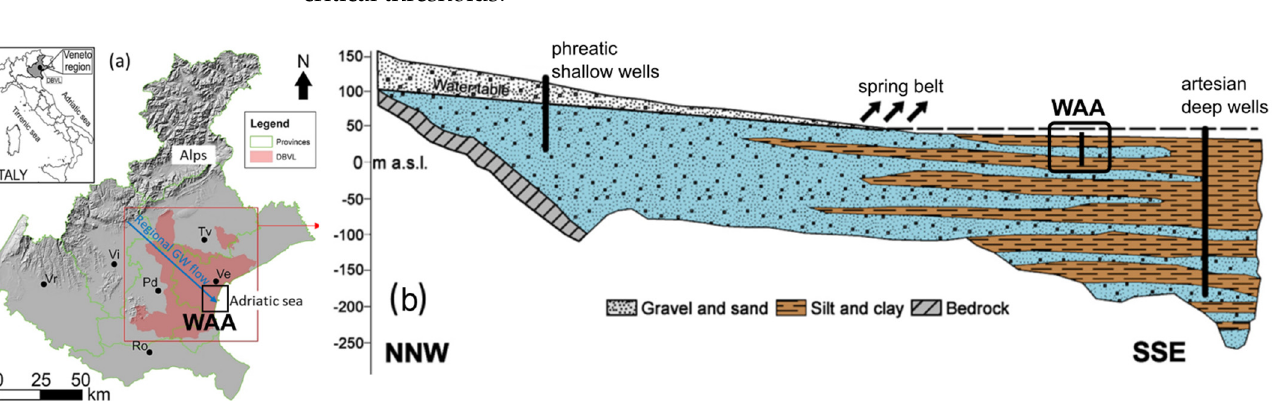
Figure 1. ( a ) Geographical location of the Drainage Basin of Venice Lagoon (DBVL), which includes the studied area (WAA). Acronyms refer to the major cities of the Veneto regions. The arrow represents the regional-scale groundwater flow direction. ( b ) Conceptual not-to-scale vertical sketch of the stratified distribution of the main hydrofacies in the VAP. The trace of this section is parallel to the groundwater flow direction depicted in frame ( a ). Note that the amount of fine-grained sediments increases towards the Adriatic sea, forming the multilevel aquifer around the WAA. The figure has been modified after [26].